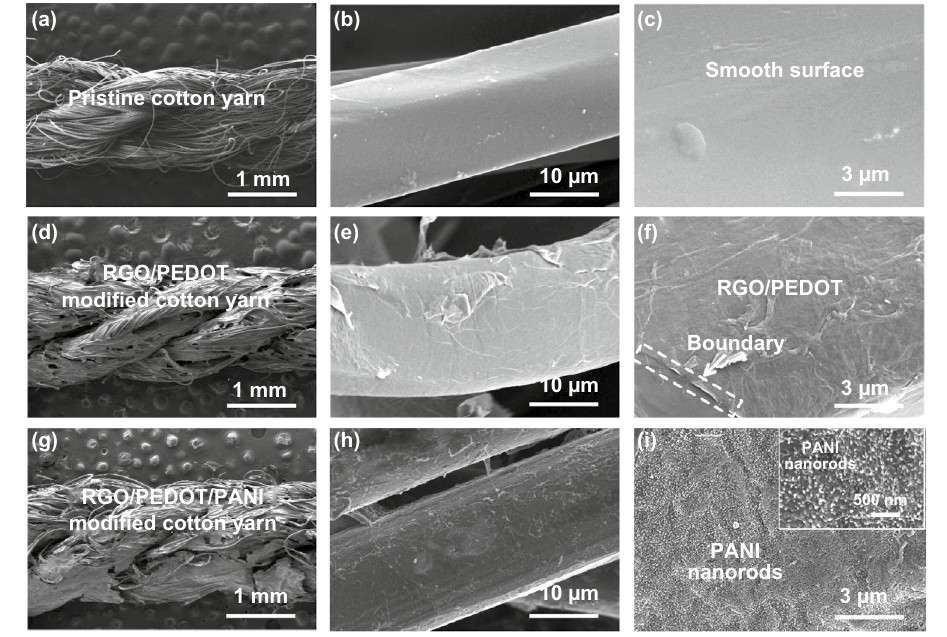
Fig. 6 SEM images of the cotton electrode at different scales: a – c pristine state, d – f modified with RGO/PEDOT, and g – i modified with RGO/ PEDOT/PANI